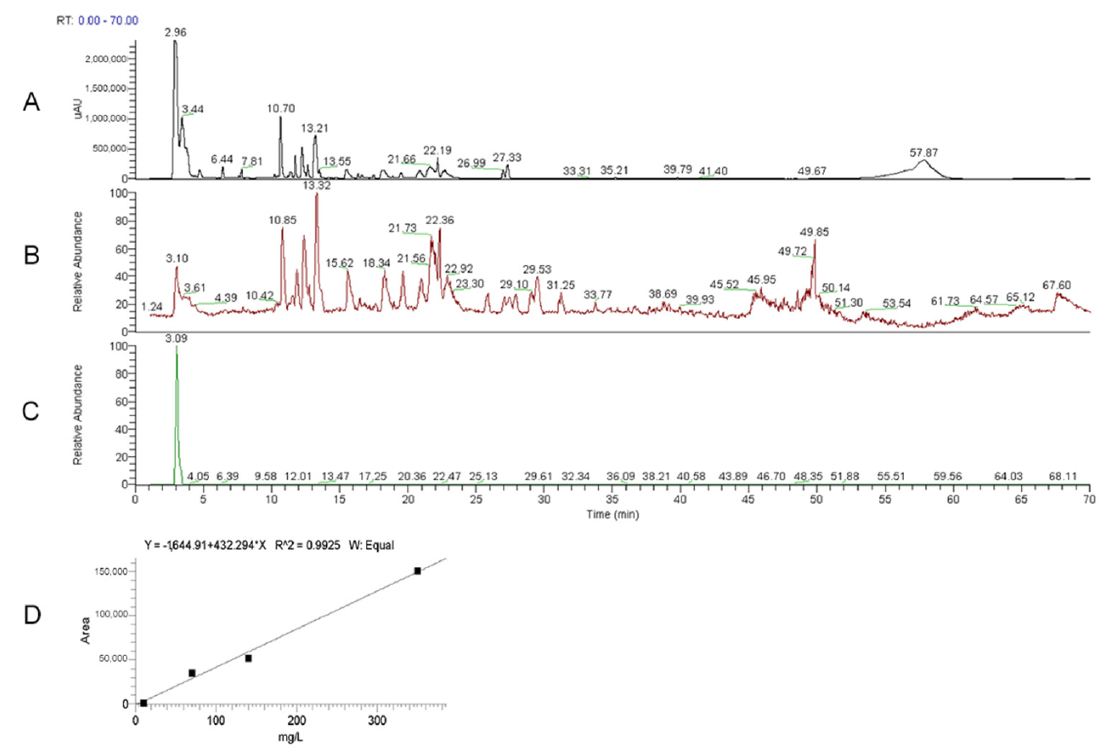
Figure 2. HPLC-UV-ESI/MS was used to quantify the ERGO amount in He2 extract. ( A ) UV (Ultra Violet) trace of He2 primordium. ( B ) ESI full MS (mass spectrum) trace of He2 primordium. ( C ) Standard molecule of L-(+)-ERGO: mass spectrum (MS)/MS Selected Reaction Monitoring m / z 230 > m / z 186 trace. ( D ) Calibration curves for ERGO.